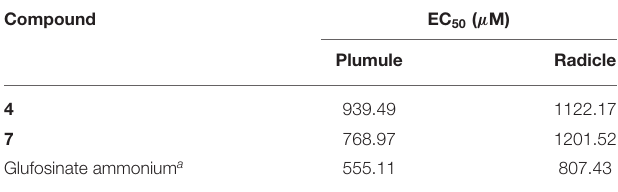
TABLE 4 | EC 50 Values of Compounds 4 and 7 in